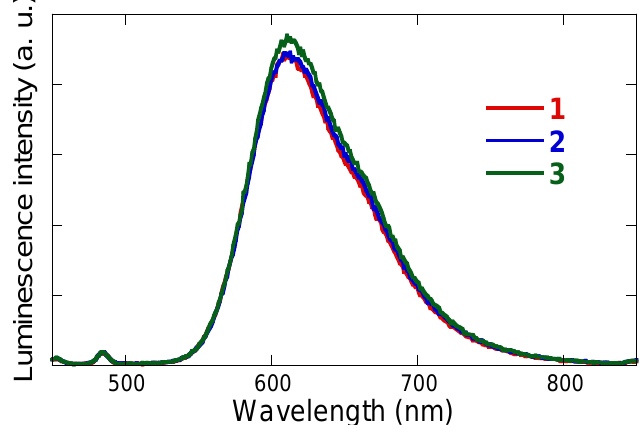
Figure 2. Luminescence spectra of [ 1 ](PF [ 3 ](PF ) ·2H O (green line) in DMF at 20 °C in air, where the excitation wavelength was 6 2 2 fixed at 425 nm and all the solutions had an equal absorbance at 425 nm